Question: Write a single sentence explaining what this figure depicts.
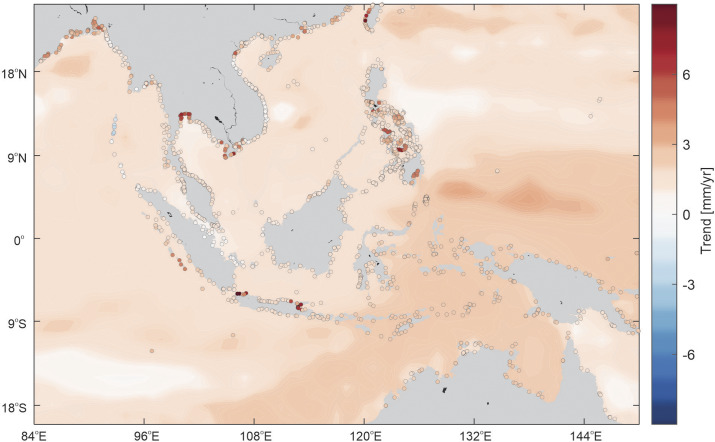
Answer: Trends in relative sea-level change (mm/yr) across the SEA region for the period 1900–2021 from the sea-level reconstruction (sum of sterodynamic effects of gravitation, rotation and deformation (GRD) related to present- day barystatic sea-level change, inverse barometer effects and glacial isostatic adjustment) produced by Dangendorf et al. ( 2024 ). Circles are coastal segments for which residual vertical land motion due to non-GIA processes was added based on a combination of GNSS, inSAR, ALT-TG and CSL-TG (Oelsmann et al., 2024 ; Dangendorf et al., 2026 ; Oelsmann et al., under review ).